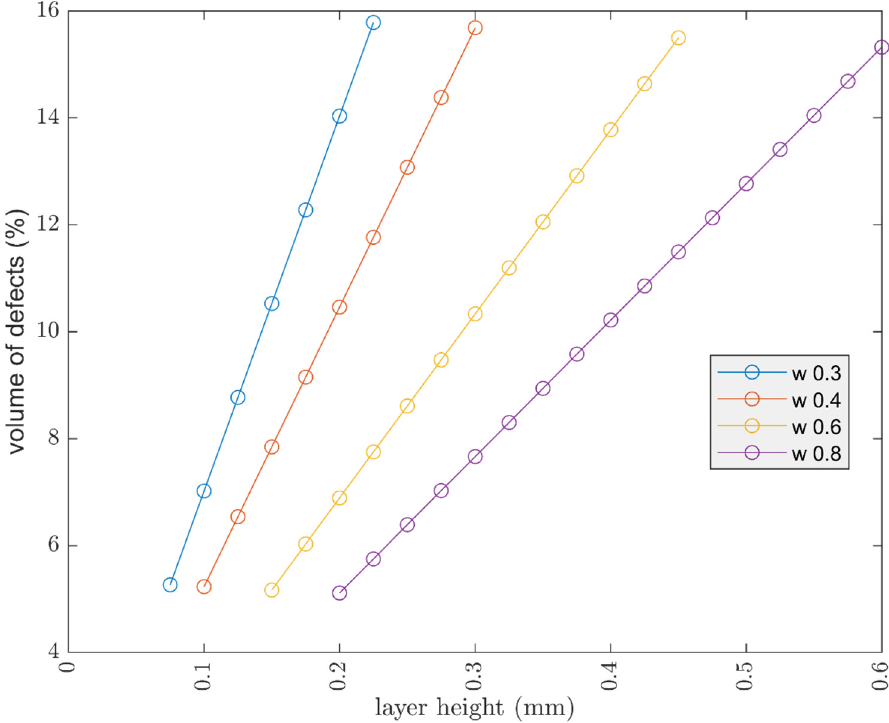
Figure 11. Different nozzle diameter compared at different layer heights; the width is equal to nozzle diameter for each of those.